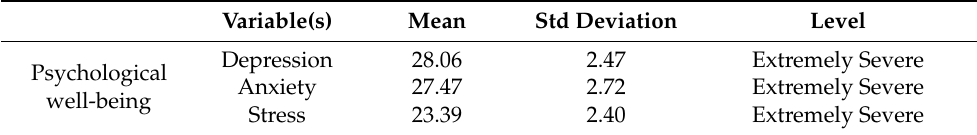
Table 3. The results of descriptive statistics and level of psychological well-being.